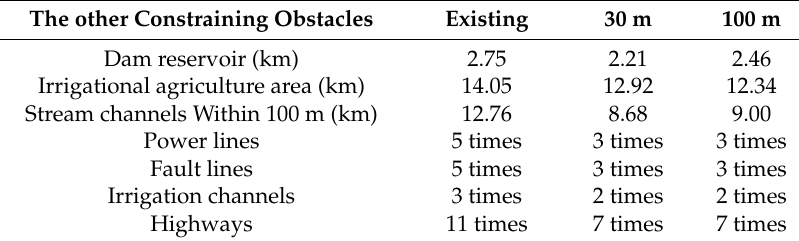
Table 6. The other constraint obstacles.